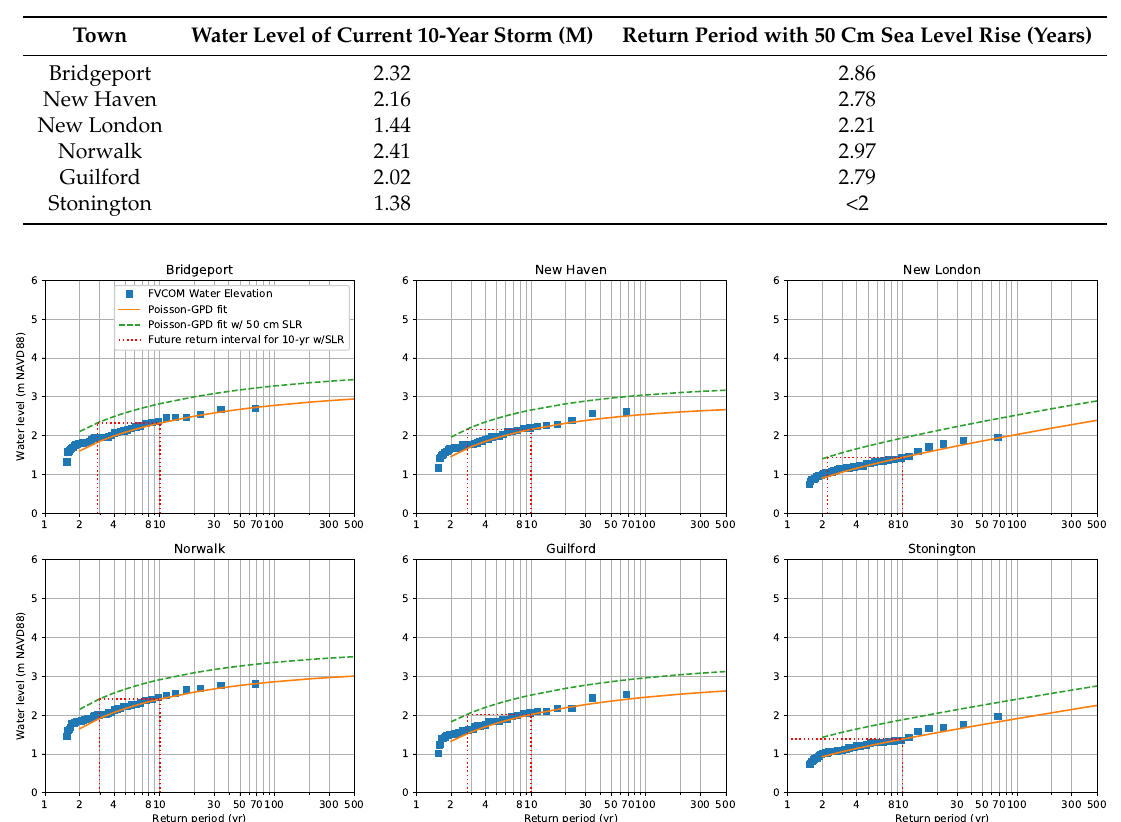
Table 6. Projected return periods for the current 10-year storm for the year 2050 with 50 cm sea level rise.